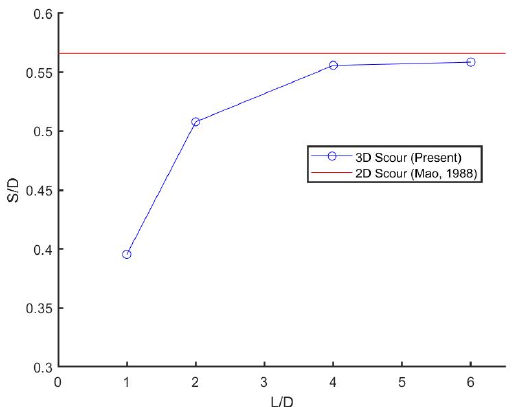
Figure 12. Dependence of the maximum scour depth on pipe length, with the horizontal line indicating the scour depth below an infinitely long